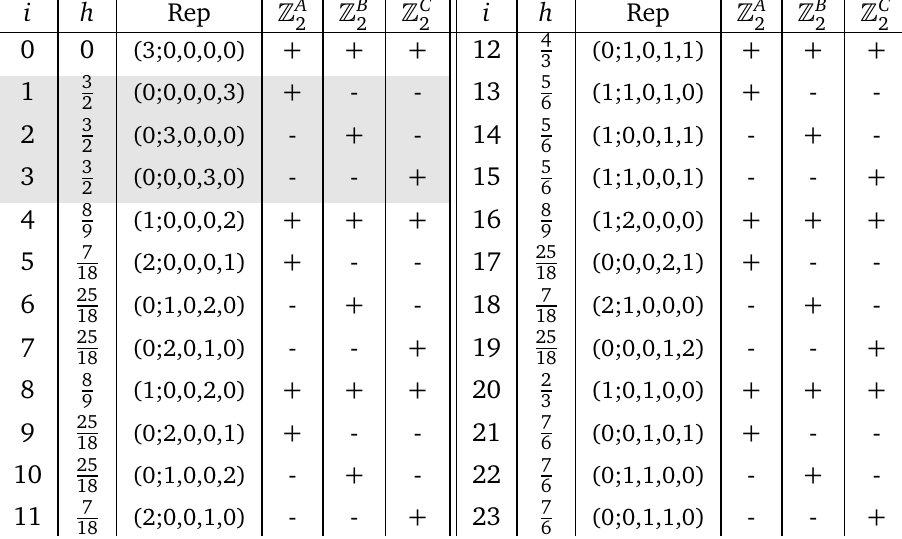
, (cid:90) B , (cid:90) C , 2 2 2 × (cid:90) 2 2